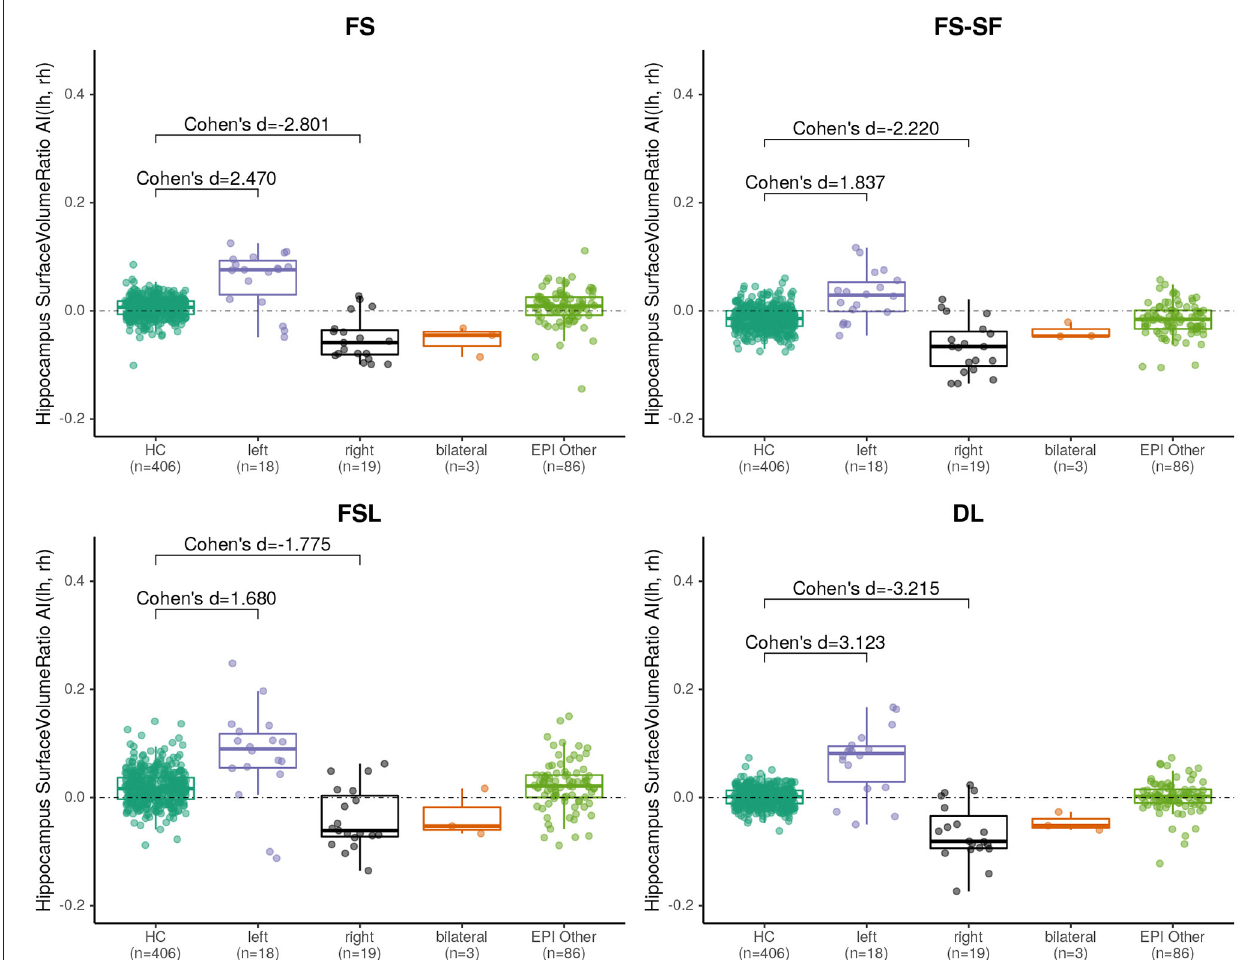
FIGURE 5 | Boxplot of the asymmetry indices (AI) of hippocampus surface-to-volume ratios derived from the four segmentation methods. Effect sizes indicate difference between healthy controls (HC), and left/right-sided hippocampal sclerosis.